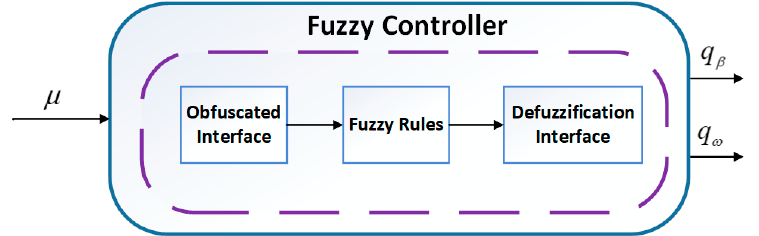
Figure 6. The fuzzy control-based variable weight coefficient regulator. Table 6. Fuzzy set of input and output.